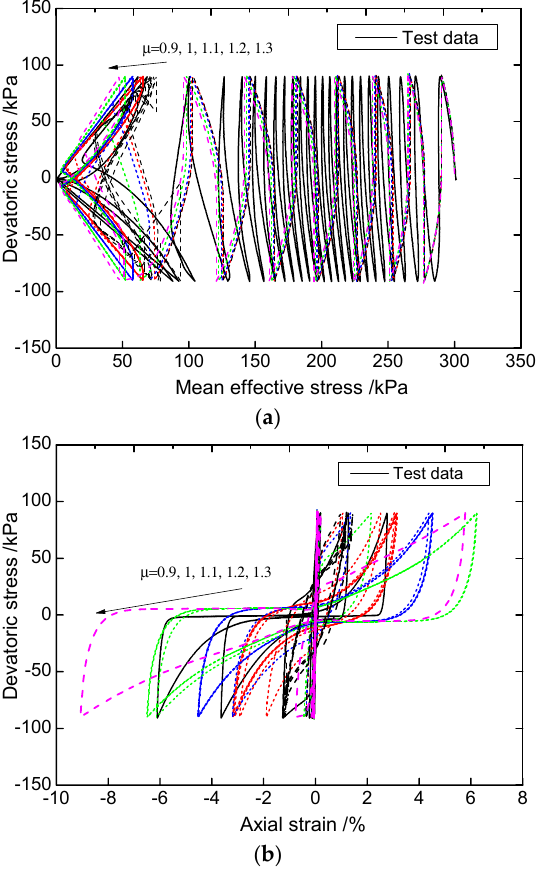
Figure 2. Model predictions of the stress-controlled undrained cyclic behavior of Karlsruhe fine sand under a stress amplitude of 90 kPa: ( a ) stress path; ( b ) stress–strain relationship. The proposed fractional model with different fractional orders µ = 1 (associated flow rule) and µ = 0.9, 1.1, 1.2, and 1.3 (non-associated flow rule) was used to calibrate the re-